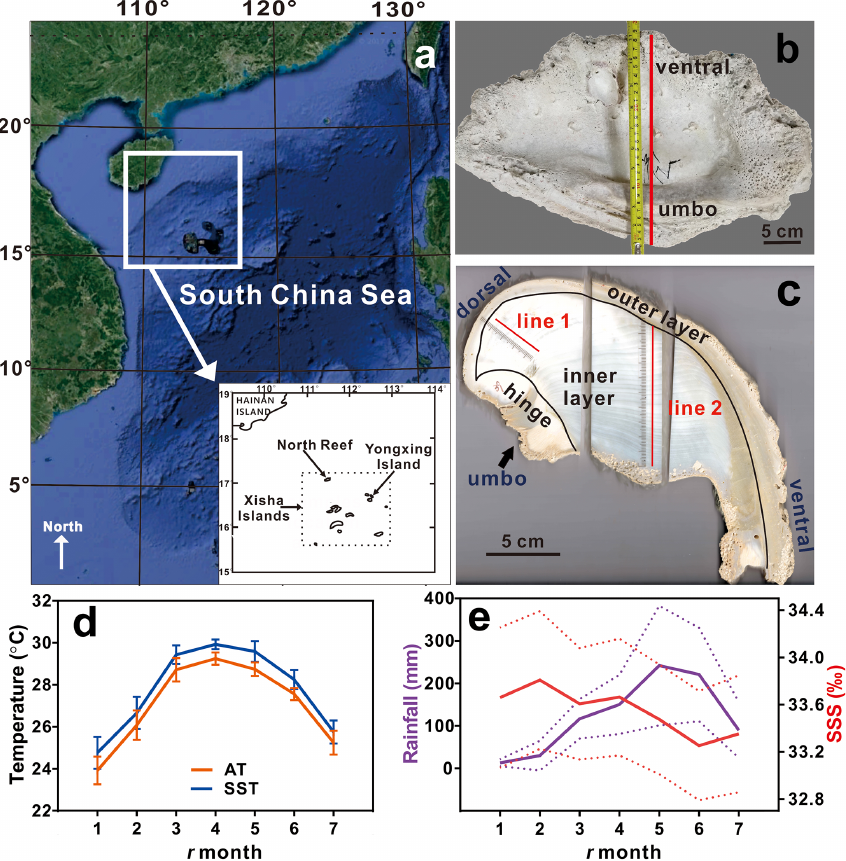
Figure 1. (a) Maps of the South China Sea (source: © Google Maps), with the location of the sample study area in the Xisha Islands. (b) Photo of original Tridacna A5. A slice was cut through the red line of Tridacna A5. (c) From the slice, different parts can be seen (hinge, inner layer, and outer layer); the red lines are the sampling lines for δ 18 O analysis. (d) Meteorological observations from the Xisha Islands from 1994 to 2005: r -monthly average air temperature (AT) and sea surface temperature (SST) with error bars revealing the highest and the lowest temperatures for that month; (e) r -monthly average rainfall and sea surface salinity (SSS) with a standard deviation (1 σ